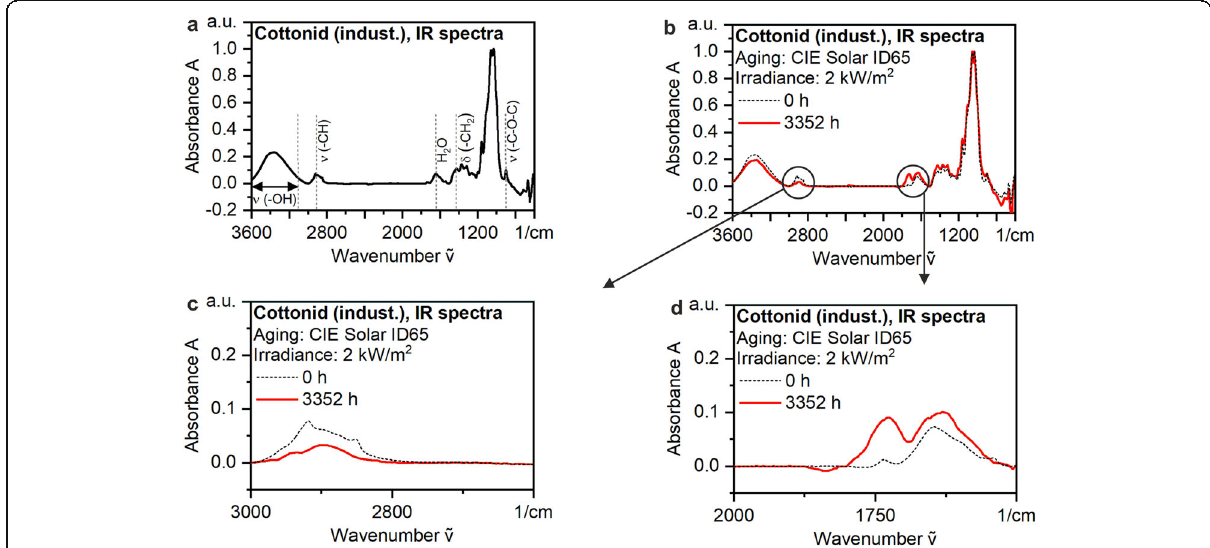
Fig. 5 Infrared (IR) spectra of industrial Cottonid material (Ernst Krueger): a In initial condition with peak definition of raw material cellulose, and b Comparative evaluation of initial condition and after optical aging (CIE solar ID65, irradiance: 2 kW/h) for t aging = 3352 h; Peak evolution due to optical aging: c Close-up at ṽ = 2.900 cm − 1 , and d Close-up at ṽ ~ 1.750 cm −